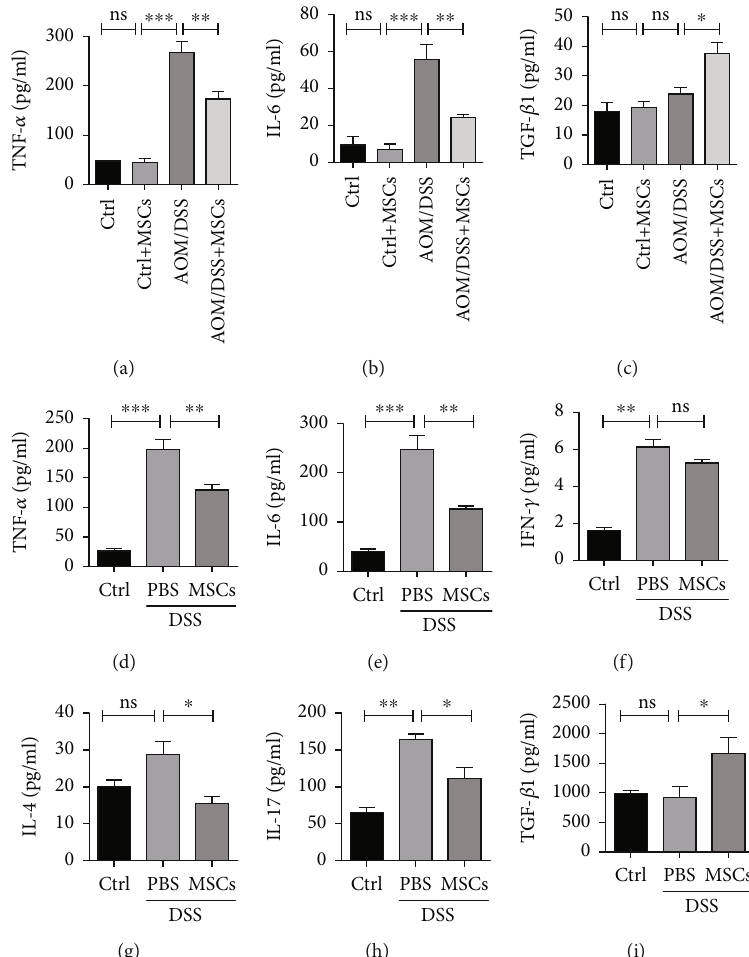
Figure 5: HUC-MSCs regulate in fl ammatory cytokine production in colitis and colitis-related colon cancer. (a – c) HUC-MSC treatment reduced TNF- α and IL-6 while increased TGF- β 1 in the serum of AOM/DSS-treated mice. (d, e) HUC-MSC treatment reduced proin fl ammatory cytokines produced by macrophages in serum caused by DSS. (f, g) HUC-MSC treatment reduced IFN- γ and IL-4 in serum of colitis mice. (h, i) HUC-MSC treatment reduced IL-17 while increased TGF- β 1 in serum caused by DSS. Error bars: mean ±